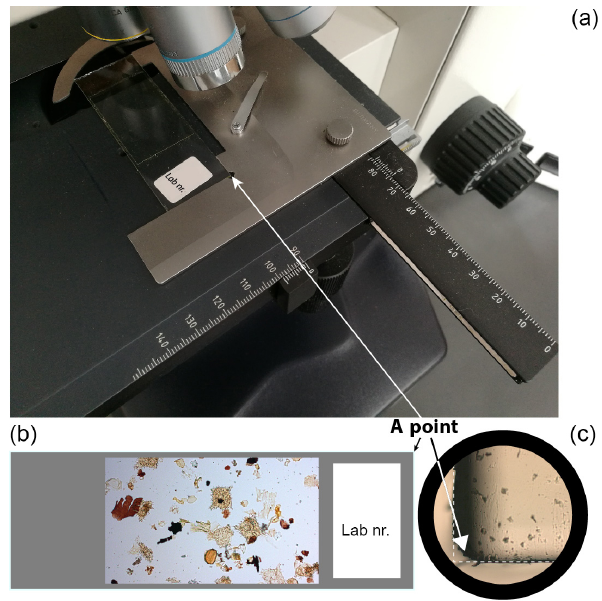
Figure A1. A technique for determining the location of speci- mens on different microscopes. (a) A typical palynological slide is placed at the microscope stage. The coordinates are taken on the millimetre-scale coordinate system ( X is horizontal; Y is vertical). On the depicted microscope the X scale is from 0 to 90 and the Y scale is from 90 to 150. (b) The A point is located in the upper right corner of the slide. (c) The A point of the slide seen under the microscope with × 10 magnification. The corner is (often) rounded, so the precise position of the A point can be extrapolated as shown here. The position of the A point is marked with an arrow. Once the slide is placed properly, the coordinates of the A point can be taken. If all the slides are analysed under the same microscope the A-point coordinates need to be taken only once. Then, slides can be analysed and coordinates of selected specimens can be taken in a traditional